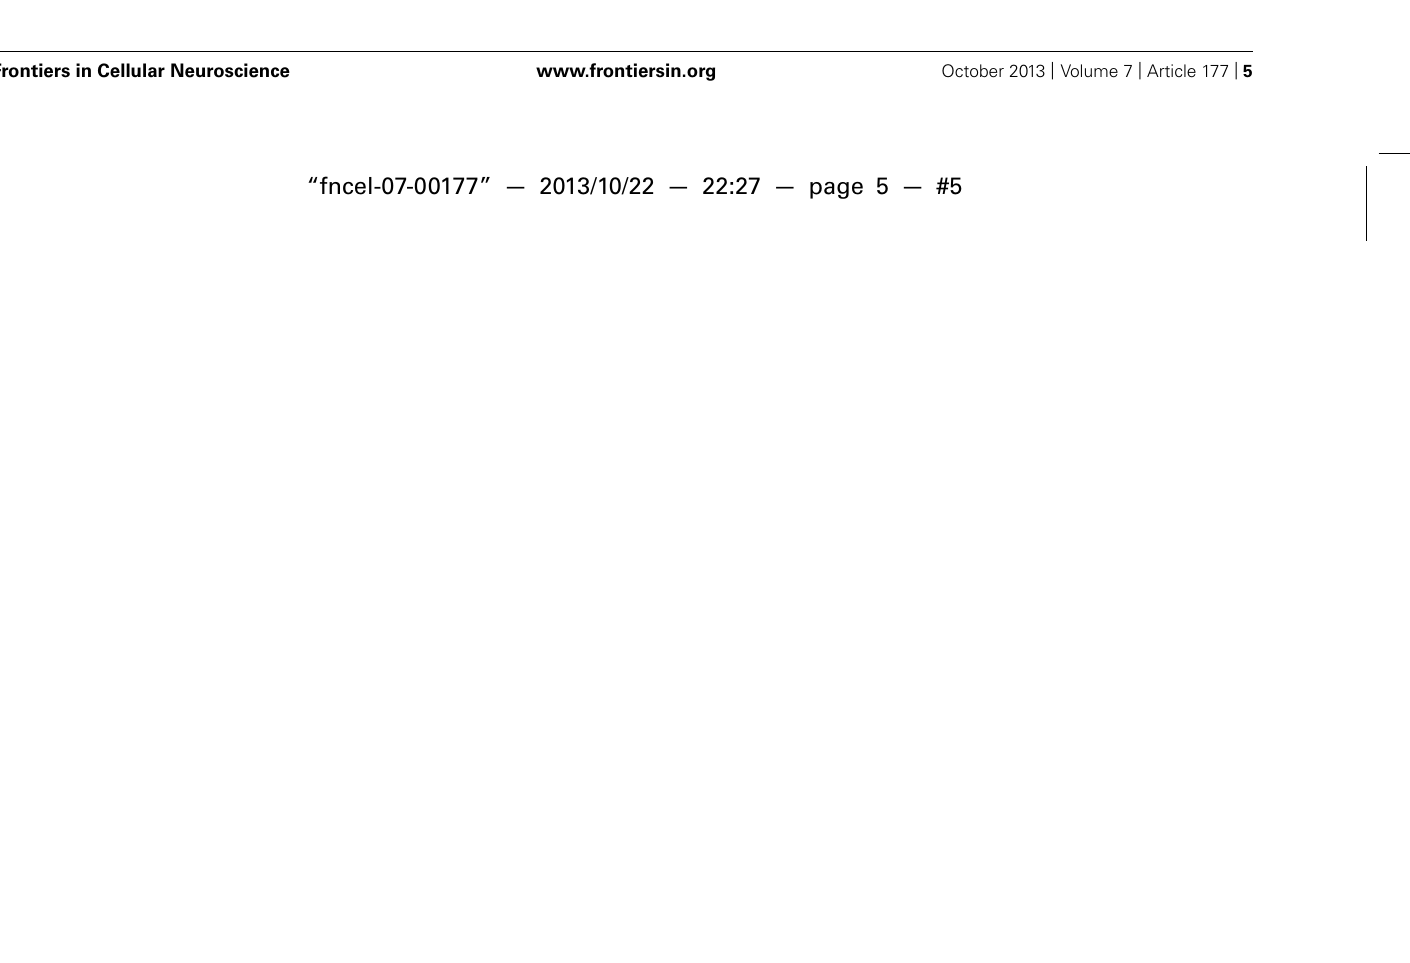
AE3, NCBE, and NDCBE which are strongly expressed in the brain.